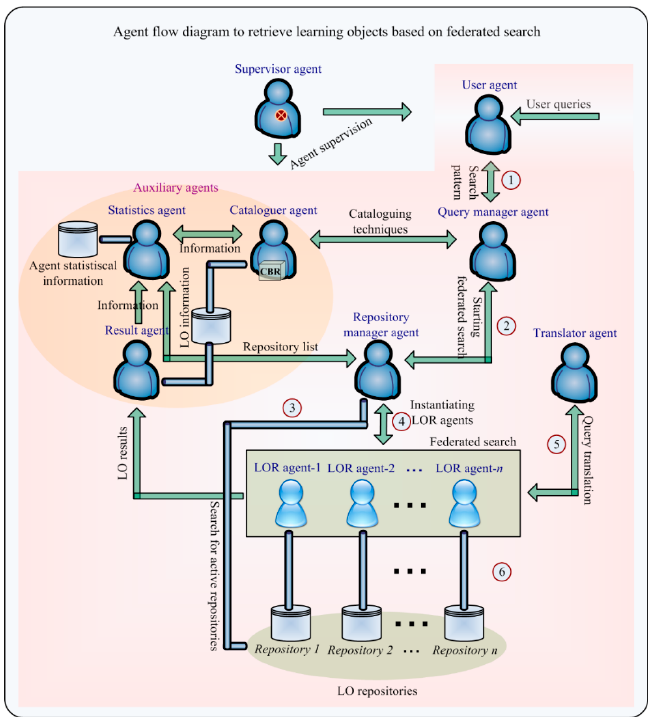
Figure 2. Flow diagram of the AIREH architecture.